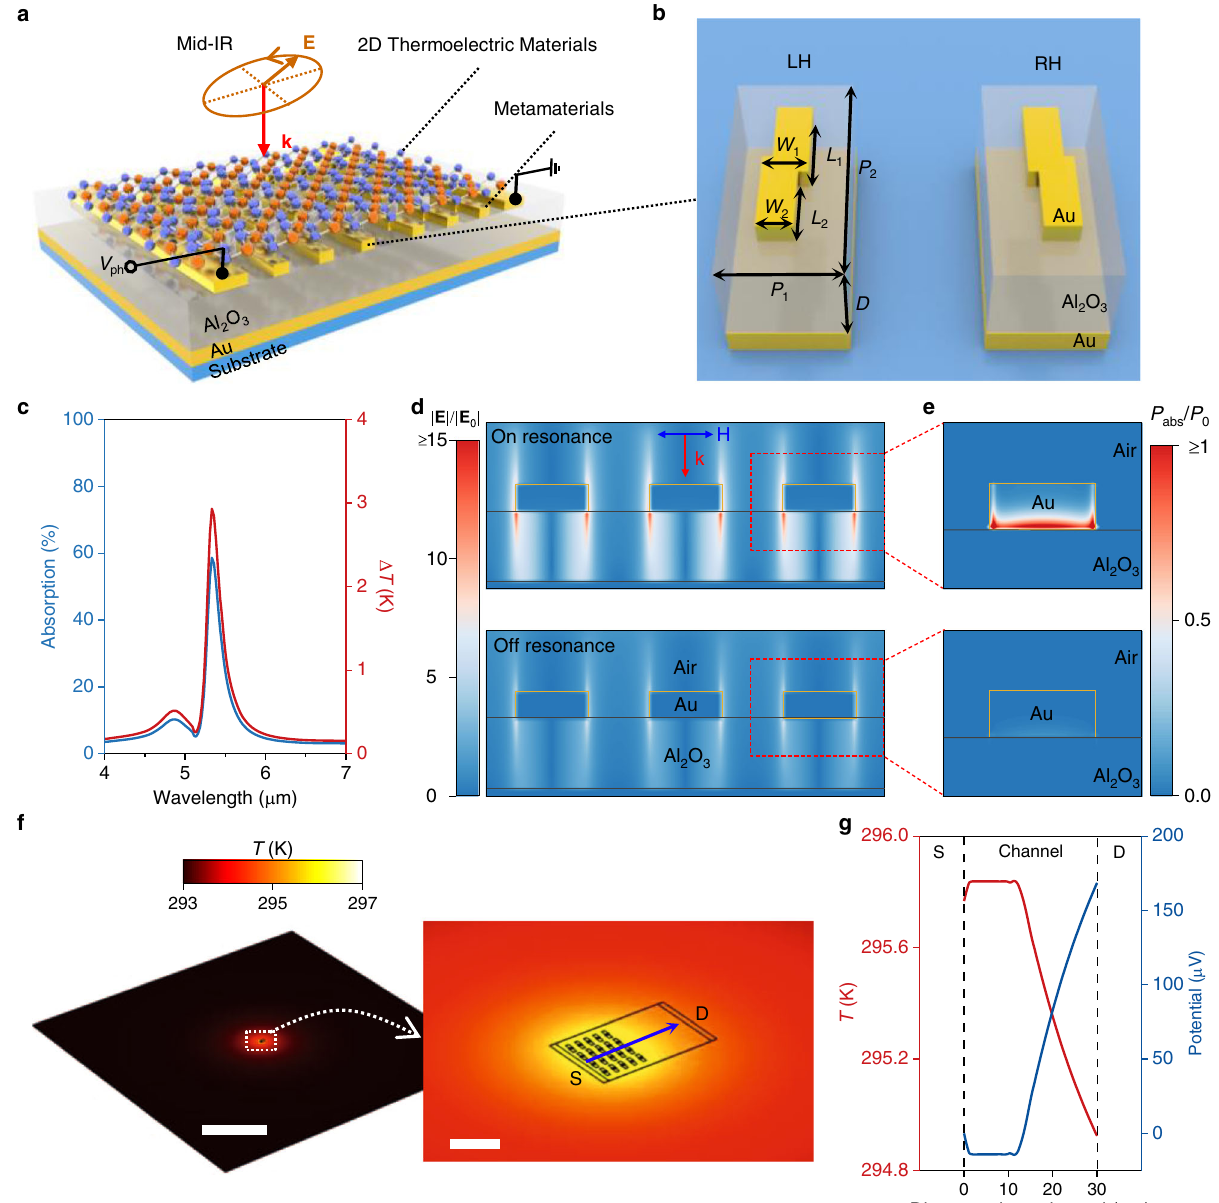
Fig. 1 | Design principle of mid-IR photodetector based on resonance photo- thermoelectric response. a Device architecture design for resonance ther- moelectric photoresponse. Here, k , E , and V ph represent wavevector, electric fi eld vector, and photovoltage, respectively. b Schematic of the chiral meta- material consisting of the chiral plasmonic meta-molecule array (Au), dielec- tric spacer (Al 2 O 3 ), and metal backplane (Au). LH and RH denote left-handed and right-handed, respectively. W 1,2 , L 1,2 , P 1,2 , and D indicate the width, length, periodic scale, and thickness of Al 2 O 3 , respectively. c Simulated absorption, andtemperature increase ( Δ T )asafunctionofwavelengthwithinput powerof